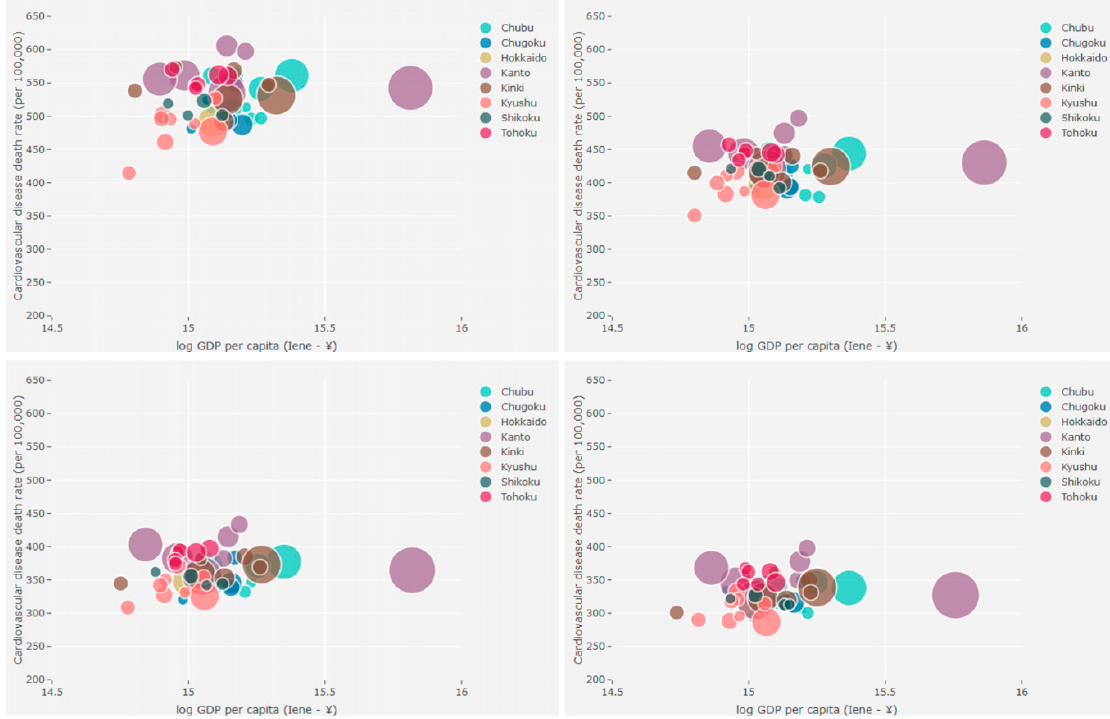
Figure 5. CVD mortality rates vs. GDP per capita vs. population, females, prefectures, Japan—time series 1996–2000 ( top left ), 2001–2005 ( top right ), 2006–2010 ( bottom left ), and 2011–2015 ( bottom right ).